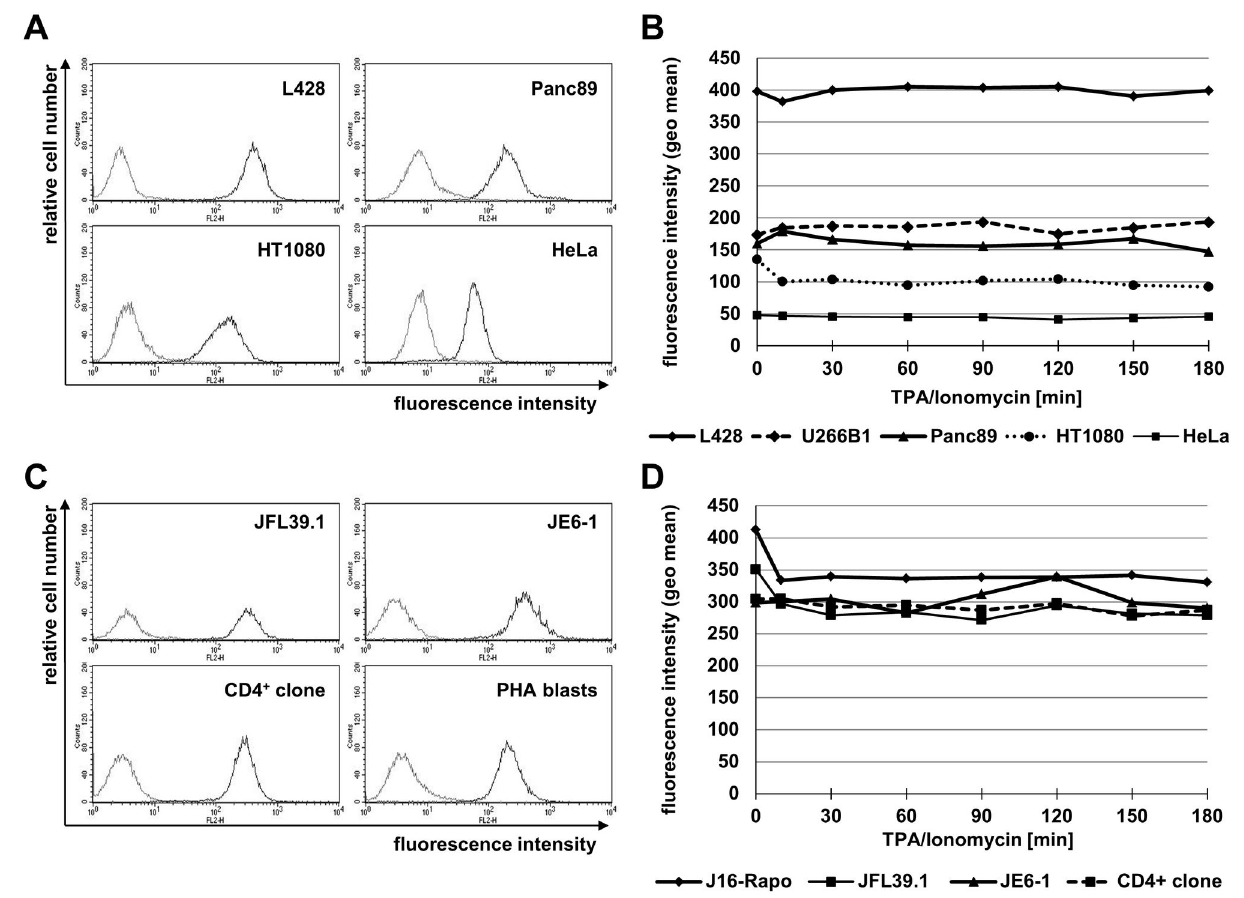
Figure 1. Surface expression and modulation of ADAM10. A. The constitutive surface expression of ADAM10 was monitored on Hodgkin’s Lymphoma (L428), pancreatic ductal adenocarcinoma (Panc89), fibrosarcoma (HT1080) and cervical carcinoma (HeLa) cell lines. Unstimulated cells were stained with an isotype control or anti-ADAM10 mAb (clone AD214Y) and PE-conjugated anti-mouse second step antibodies. Histograms display fluorescence intensities against relative cell numbers. B. Activation- dependent alterations in ADAM10 surface abundance were monitored on tumor cells (also including U266B1 myeloma cells) at the indicated time points after stimulation with TPA and Ionomycin. For each time point, cells were stained with anti-ADAM10 mAb and PE-conjugated anti-mouse second step antibodies. Individual data points represent geometric mean values calculated from individual histograms using CellQuestPro. C. The indicated leukemic and untransformed T cell populations were analyzed for constitutive expression of ADAM10 as described for panel A. D. Activation-induced alterations of ADAM10 on Jurkat variants or cloned T cells were analyzed upon stimulation with TPA and Ionomycin as described for